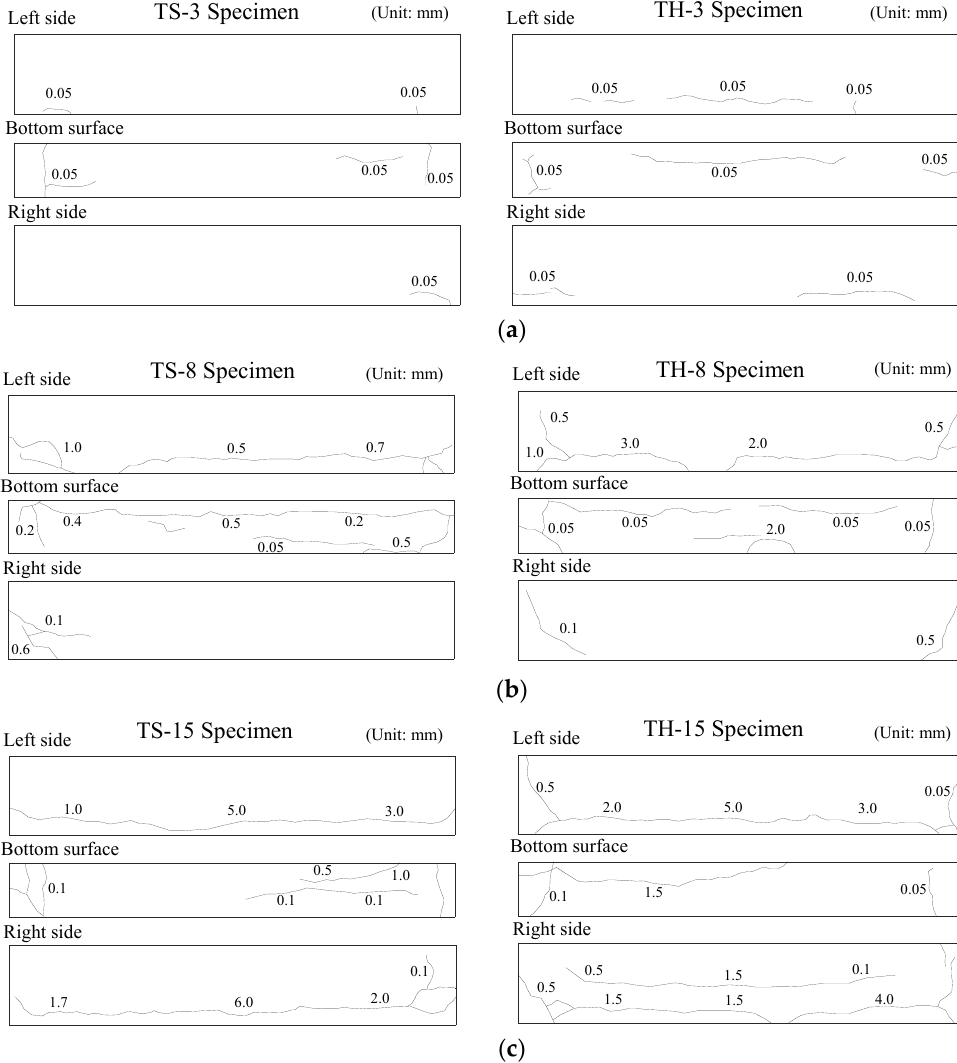
Figure 5. Crack patterns induced by corrosion in longitudinal reinforcement. ( a ) Target corrosion rate of 3%; ( b ) Target corrosion rate of 8%; ( c ) Target corrosion rate of 15%.